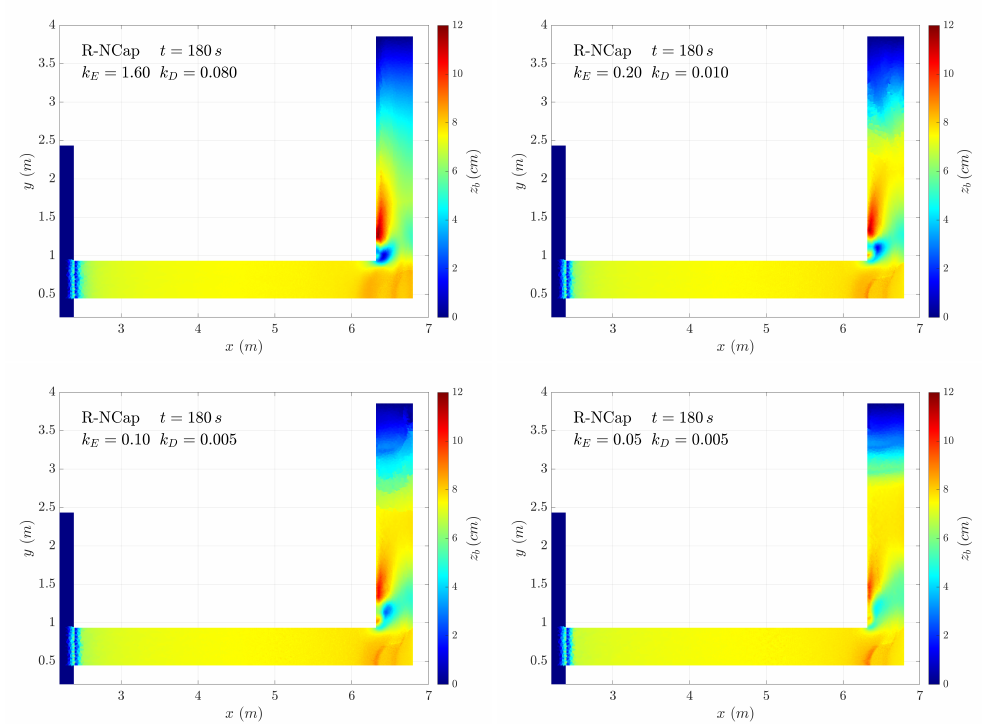
Figure 7. Bed elevation z b 2D maps obtained with the R-NCap model at t = 180